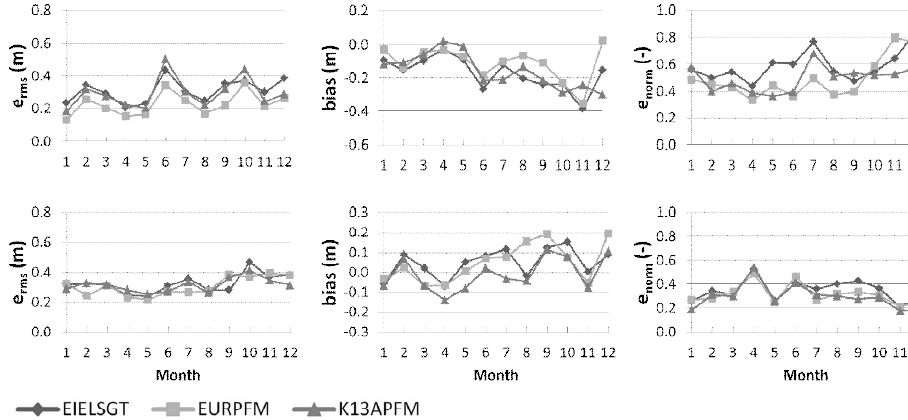
Figure 10. Monthly errors of swell height (first row) and wind sea component (second row).